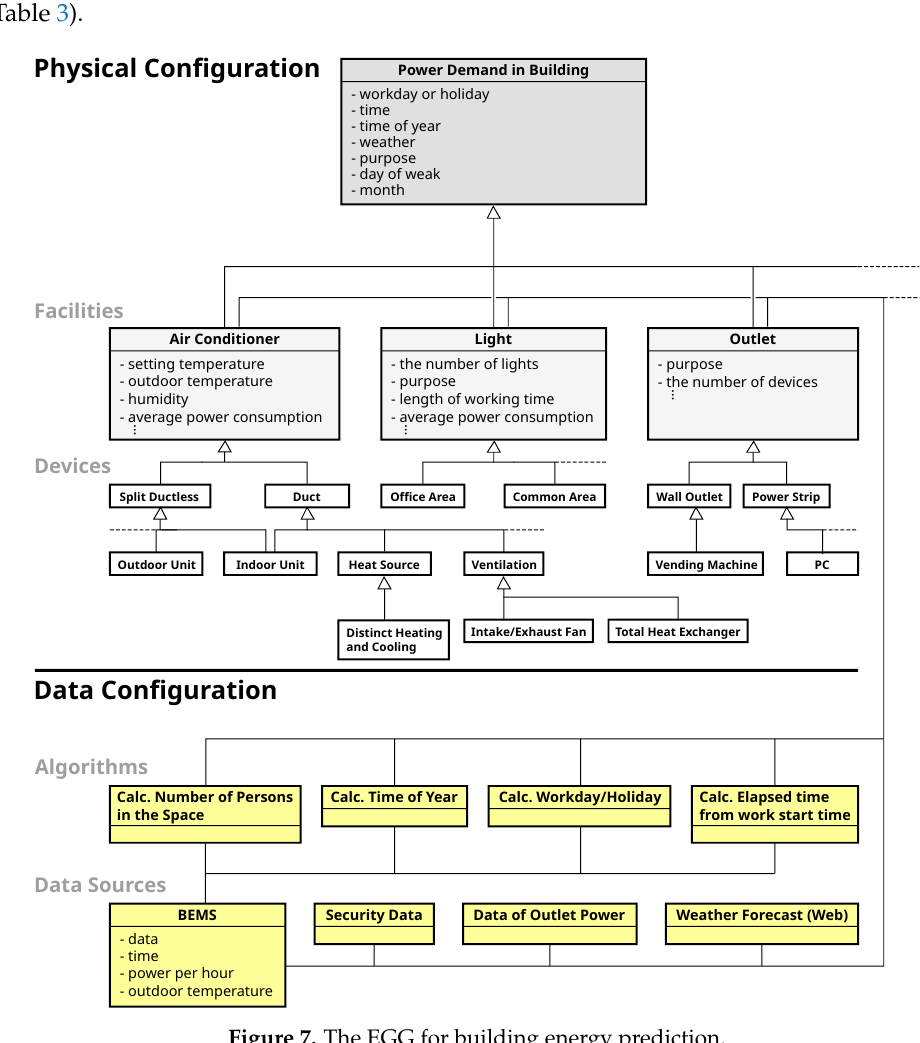
Figure 7. The EGG for building energy